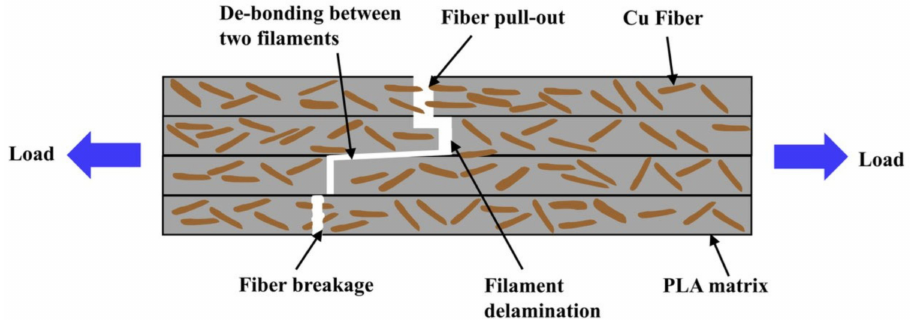
Figure 8. Depiction of fibers in FDM 3D-printed material and the di ff erent defects that occur with stress including fiber pull-out, filament delamination, debonding, and fiber breakage. Reproduced with permission from [49], Wiley,